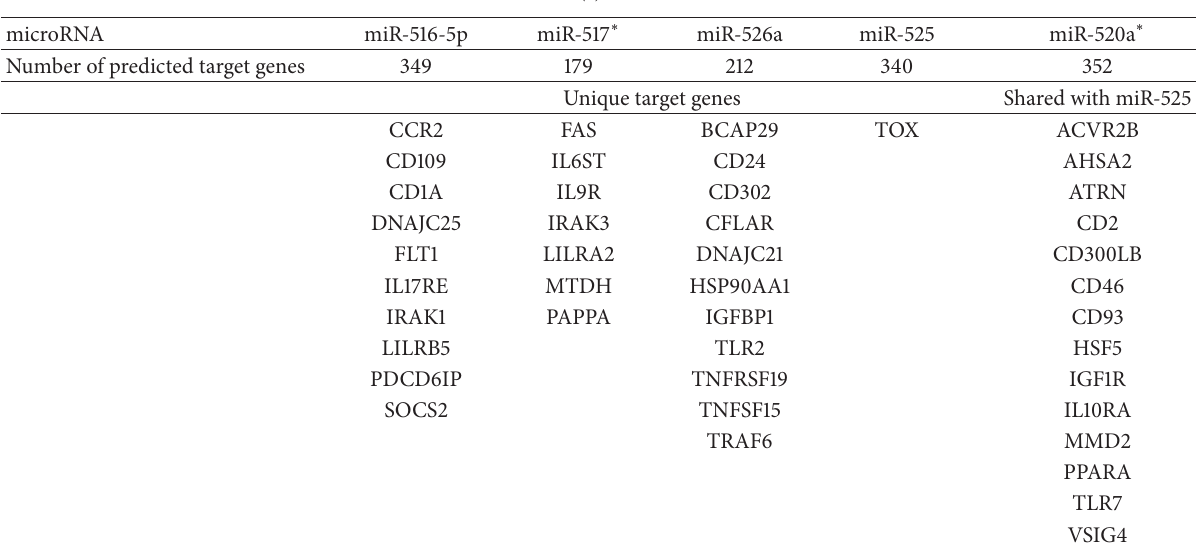
Table 2: (a) Function and functional relationship analysis of target genes of differentially expressed extracellular C19MC microRNAs in preeclampsia in relation to immune system response. (b) Function of target genes of differentially expressed extracellular C19MC microRNAs in preeclampsia in immune system